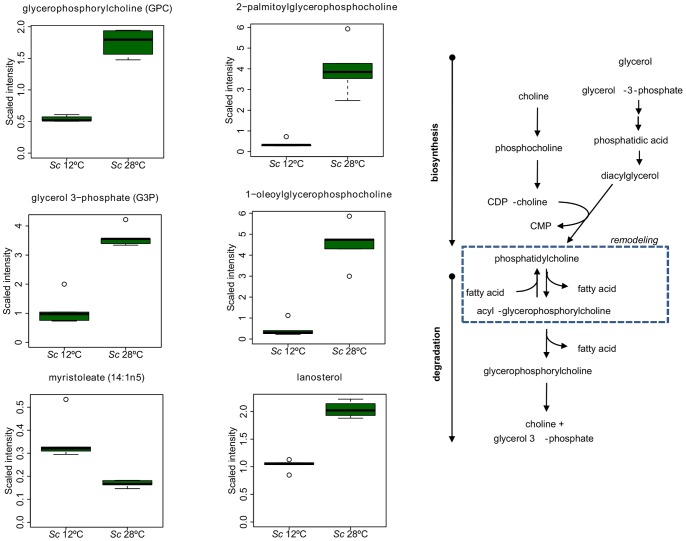
Phosphatidylcholine biosynthesis and degradation in S. cerevisiae.Metabolic differences in the Sc growing at 12°C and 28°C. Box legend: bar inside the box represents the median value, upper bar represents maximum of distribution, lower bar represents minimum of distribution and the circle represents extreme data points.